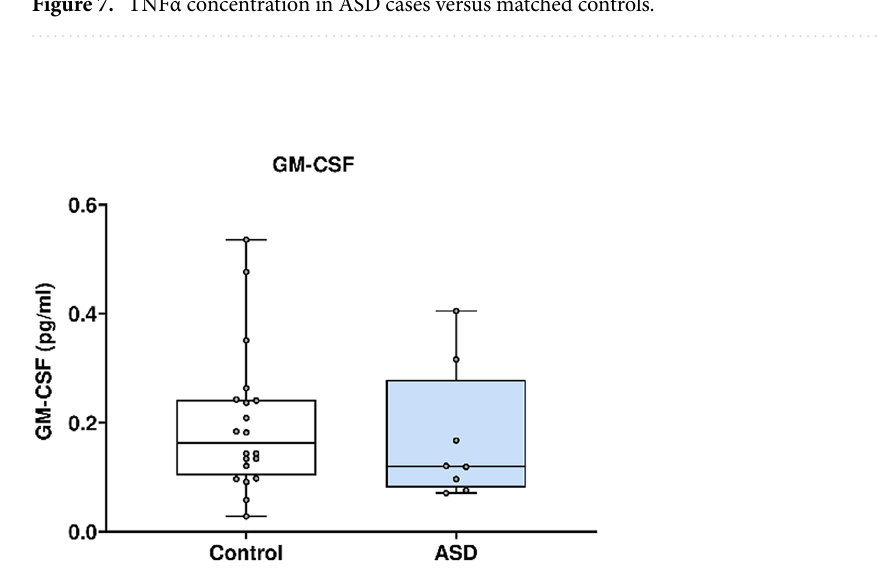
Figure 8. GM-CSF concentration in ASD cases versus matched